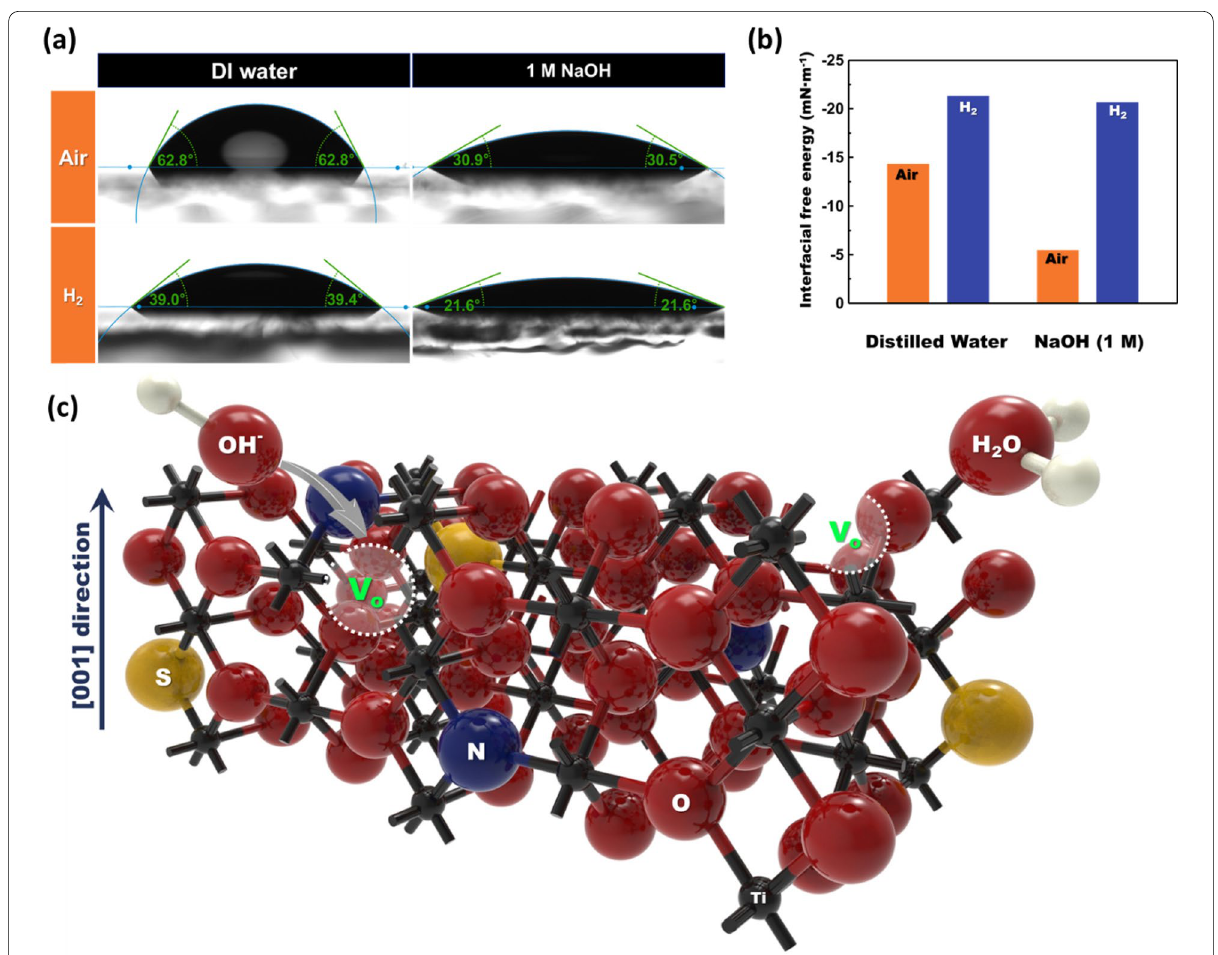
Fig. 9 a The optical images captured by contact angle measurement system. The average contact angles were calculated using several images obtained by high speed camera. TiO 2 thin films having 100 nm thickness were used. The contact angles between the films and DI water, 1 M NaOH solution were measured. b Comparison chart for Interfacial free energy. Interfacial free energies were calculated using contact angle and Young’s equation. c Schematics of surface reaction at the TiO 2 surface. Oxygen vacancies at the surface, produced by H 2 treatment, promote an easy adsorption of the water molecules and hydroxyl